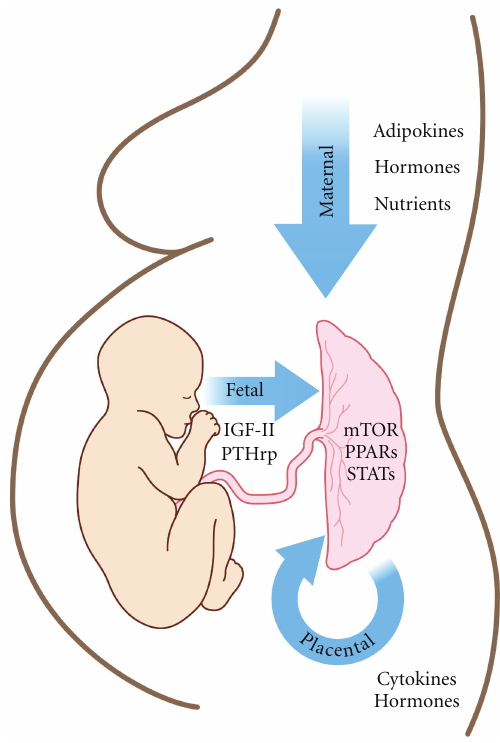
Figure 2: Placental function is likely regulated by numerous factors of fetal, maternal, and placental origin. Fetal signals a ff ecting placental function include IGF-II and PTHrp. The e ff ects of maternal factors, including adipokines, hormones, and nutrient levels, on placental function have been investigated in various models such as cultured trophoblast cells, placental explants, and perfused placenta. The placenta also expresses a wide array of molecules which are released into both fetal and maternal circulations. These substances may impact on the placenta itself in an autocrine/paracrine fashion. Integration of numerous, and sometimes divergent, signaling by intracellular regulatory pathways such as mTOR, PPAR, and STAT has been demonstrated to a ff ect placental nutrient